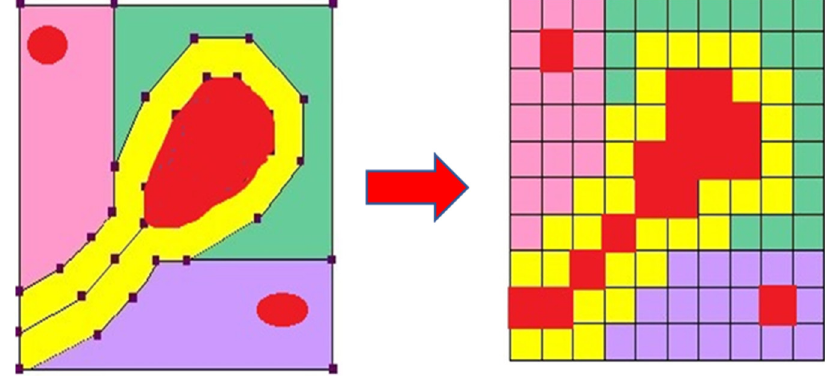
Figure 6. Conversion of a shape file into raster form using the rasterisation tool.